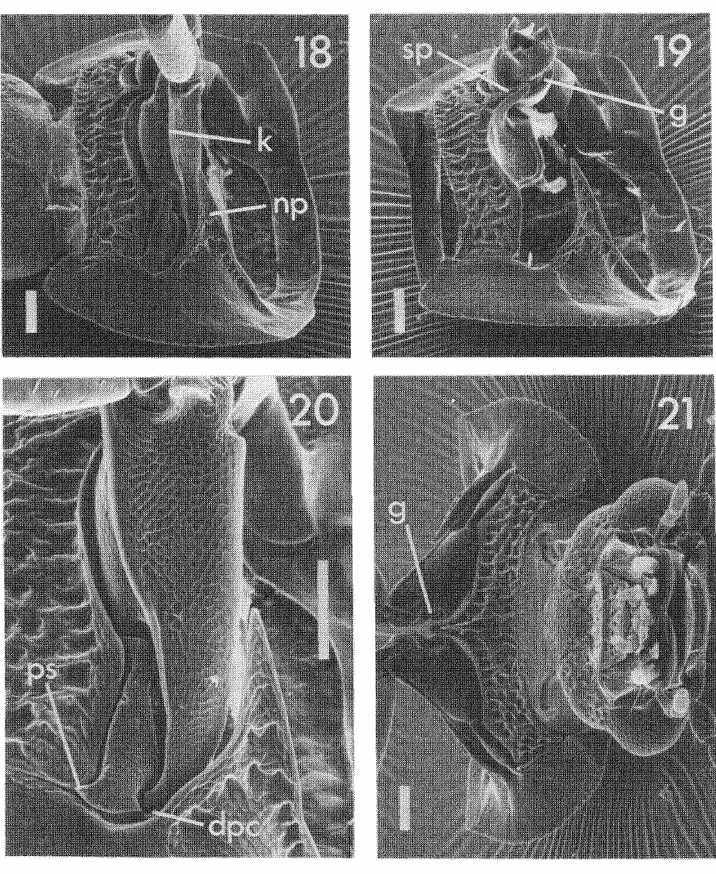
Figs. 18-21. Glypholoma pustuliferum. 18-19. Prothorax, ventrolateral view, with and without procoxa and trochantin, respectively. 20. Right procoxa and surrounding area, ventrolateral view, with coxa rotated anteriorly. 21. Prothorax and head, anteroventral view. dpc dorsal pleural-coxal articulation; g mesal articulating groove of coxa; k external coxal keel; np- postcoxal process of pronotum; ps pleural-sternal articulation; sp prosternal intercoxal process. Scale lines 0.1